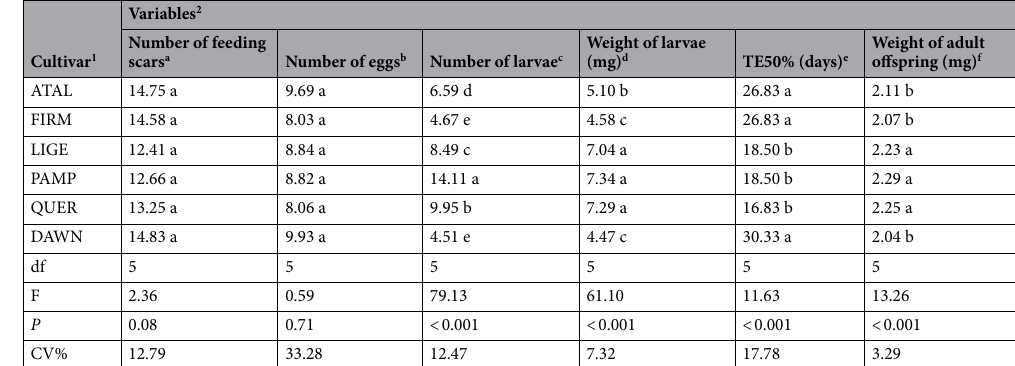
Table 1. Densities and performance variables of South American rice water weevil Oryzophagus oryzae on six rice cultivars in a 2-year field screening for antixenosis and antibiosis. 1 Rice cultivars: ATAL = BRS Atalanta; FIRM = BRS Firmeza; LIGE = BRS Ligeirinho; PAMP = BRS Pampa CL; QUER = BRS Querência; DAWN = Dawn. 2 Variables: a = number of feeding scars; b = number of eggs [both averages from 5, 8, and 11 days after flooding (DAF)]; c = number of larvae; d = weight of larvae (mg) (both averages from 15, 25, and 35 DAF); e = time (days) required to reach 50% adult population (TE50%); f = weight of offspring adults (mg) (average of male and female). Average values followed by the same letter does not differ significantly by the Scott Knott test ( P < 0.05).